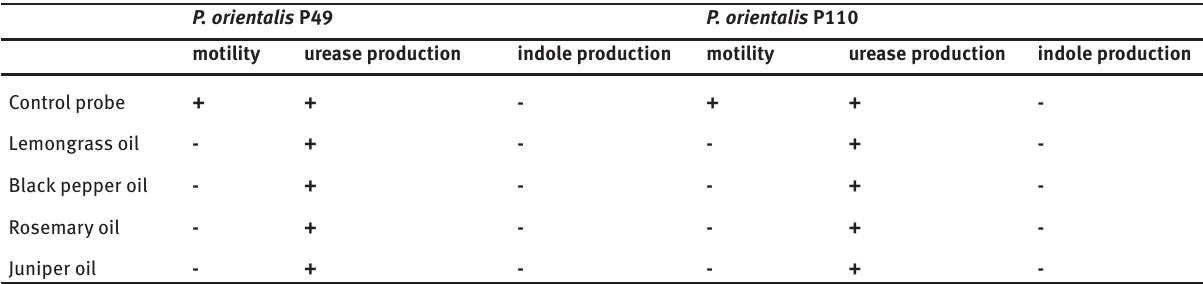
Table 3: The influence of sub-inhibitory concentrations of plant oils into motility and ammonia and indole production in P. orientalis